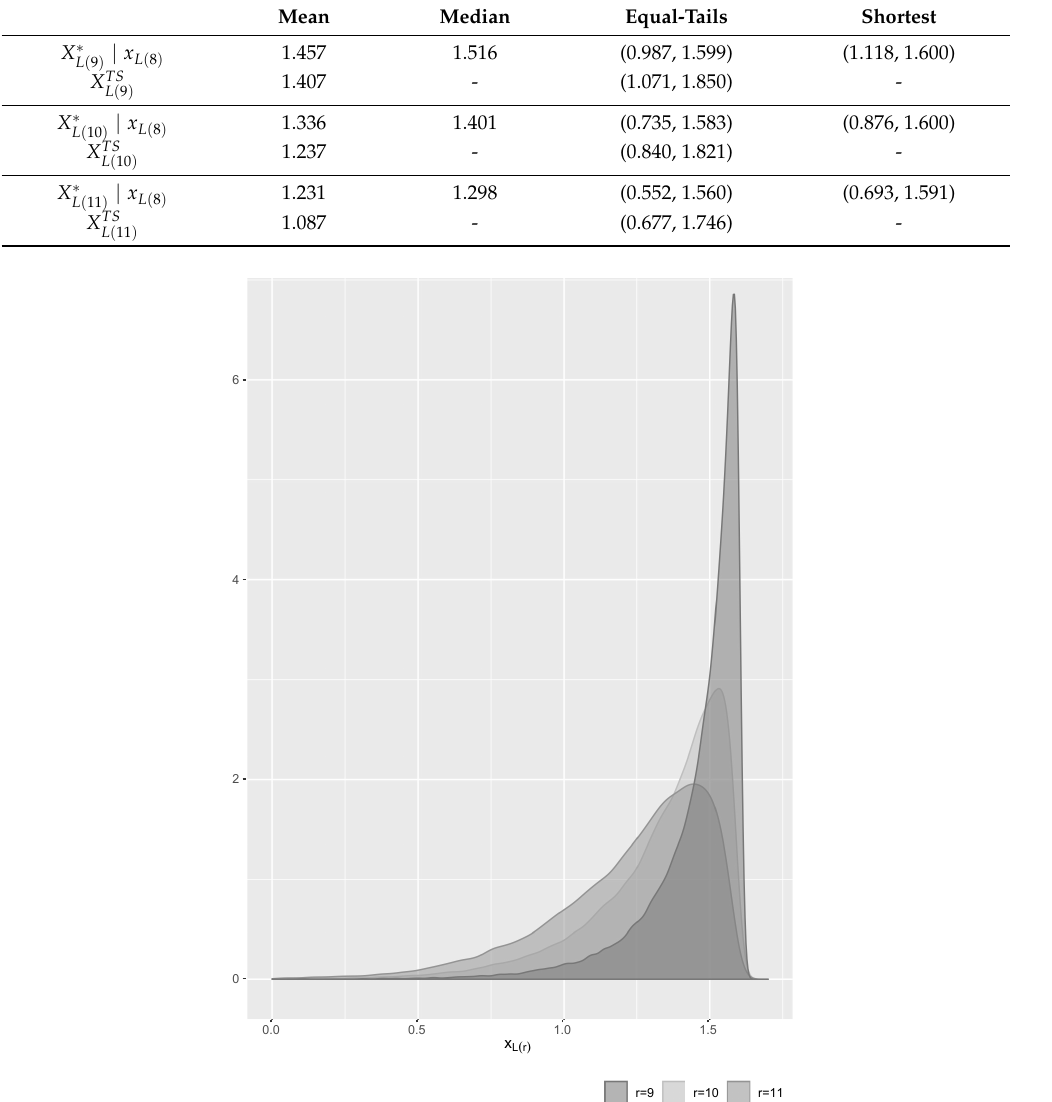
Figure 6. Estimated kernel density functions for X ∗